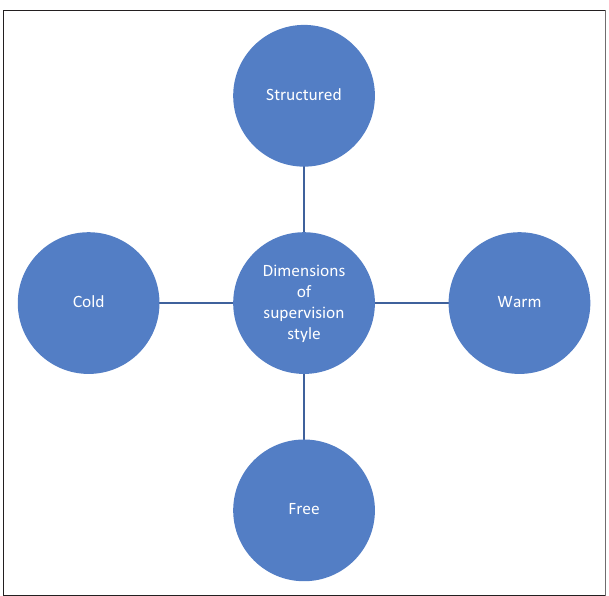
FIGURE 1: Conceptualisation of supervision styles.